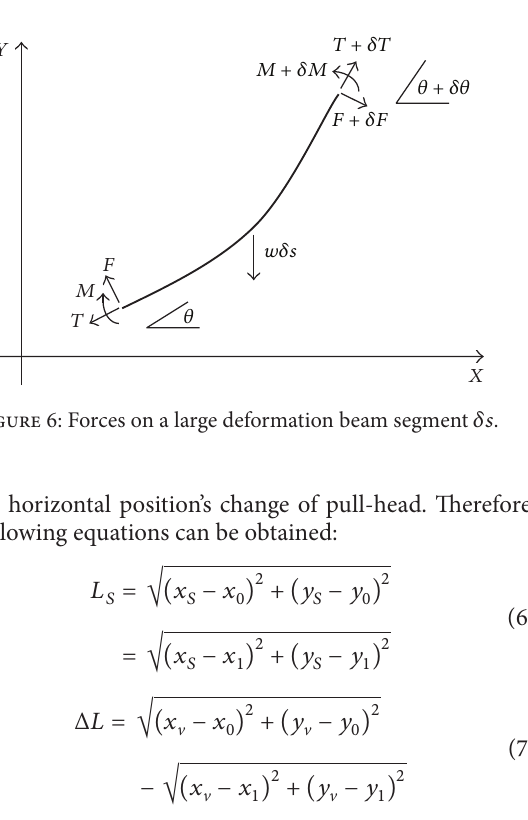
Figure 5: Geometrical relationship for pull-in step.